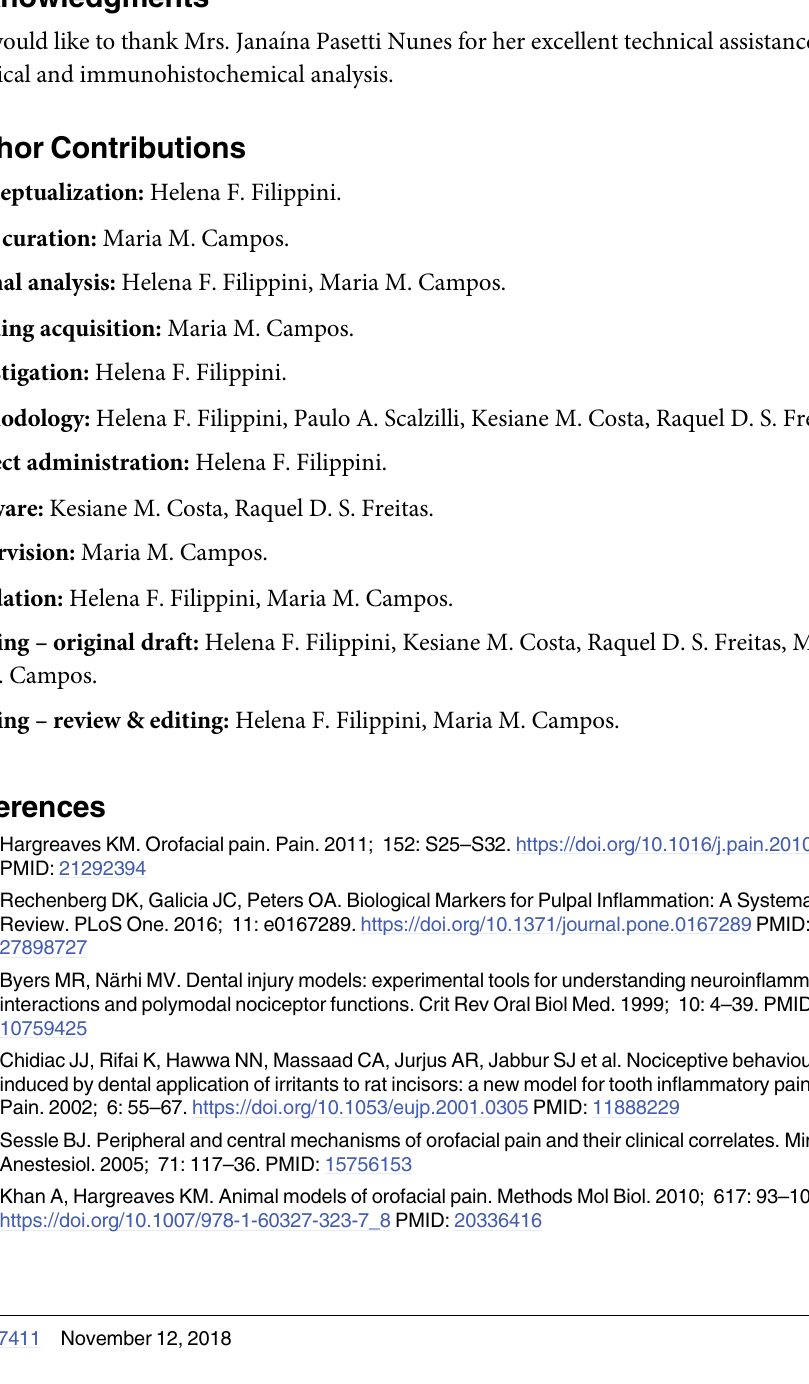
S1 Table. Serum levels of pro-inflammatory cytokines in the different experimental